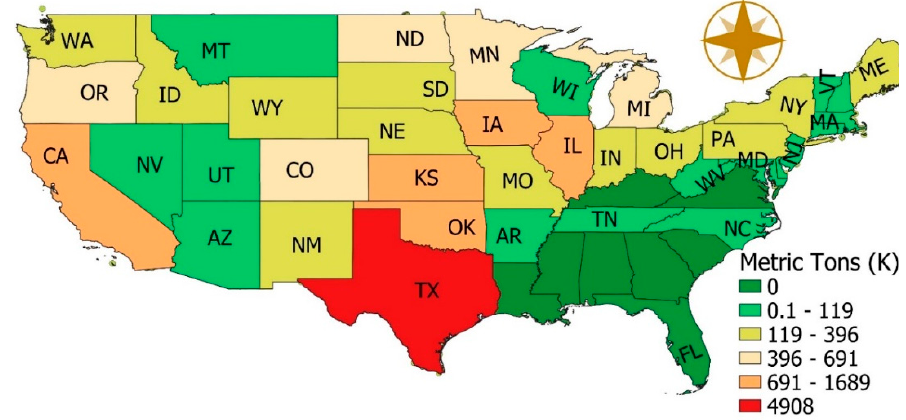
Figure 6. US map showcasing global wind turbine mass inventory per state up to 2020.